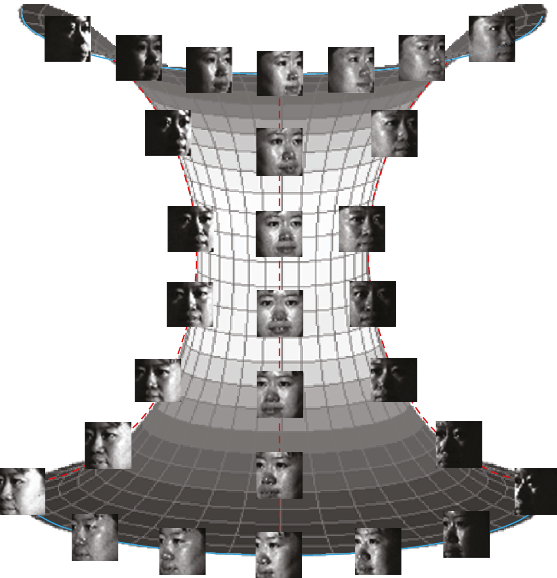
Figure 2: Ideal factor-specific submanifolds in an entire manifold on which face images lie. Each red curve connects face images only due to varying viewpoint while each blue curve connects face images only due to varying